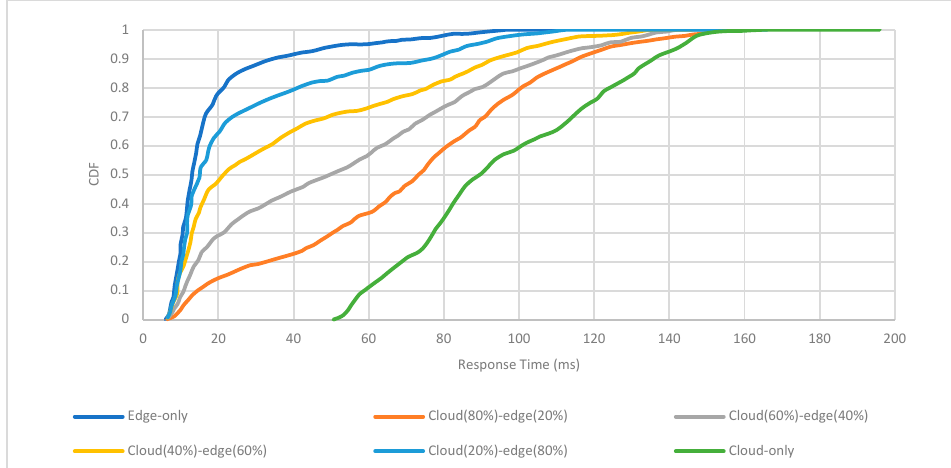
Figure 12. Response time CDF for different resource distributions.